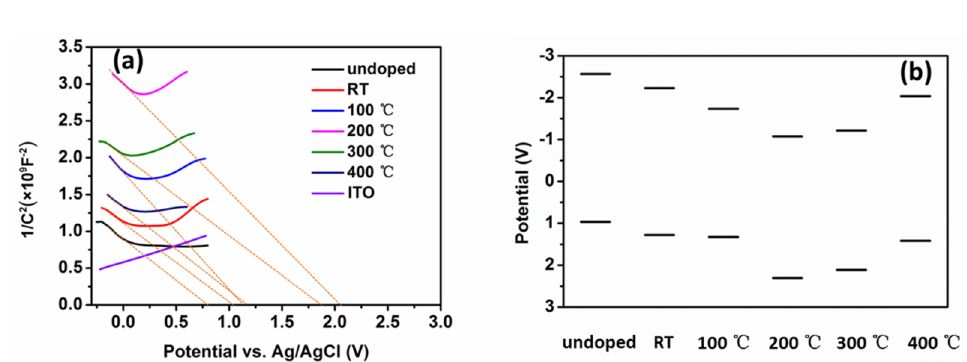
Figure 9. ( a ) Mott–Schottky plots and ( b ) schematic energy band diagrams of NiO thin films deposited at different substrate temperatures.